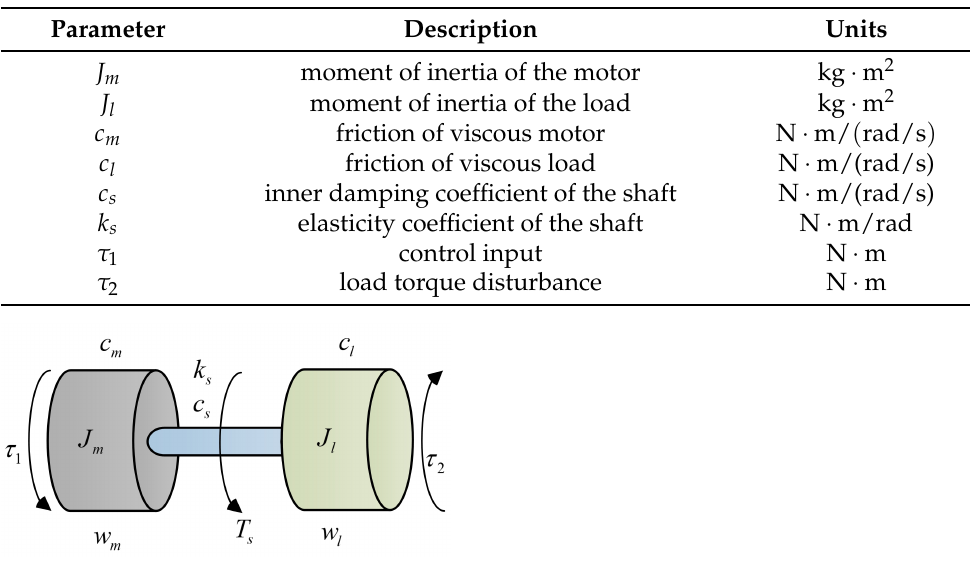
Figure 2. Two-mass